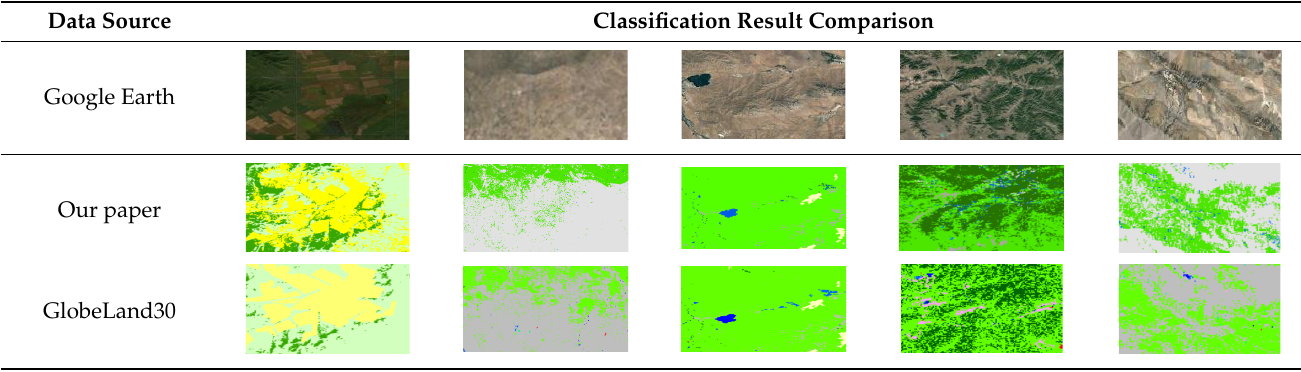
Table 6. Comparison of land use changes in Mongolia and other regions.